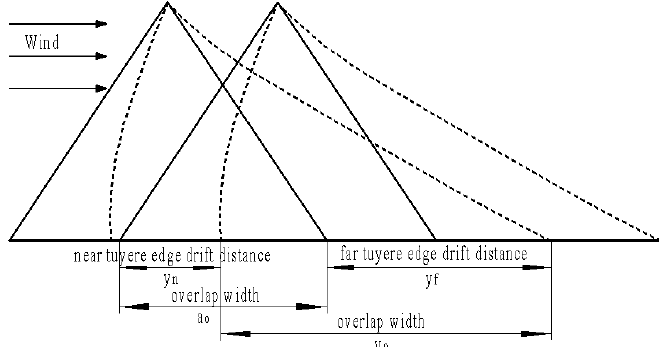
Figure 4. The natural curve of droplets is shown by solid lines and the drift curve influenced by wind is shown by dotted lines, a 0 is overlap width, y 2 is the drift distance of near tuyere edge, y 3 is the drift distance of far tuyere edge, and y 4 is the overlap width influenced by wind.